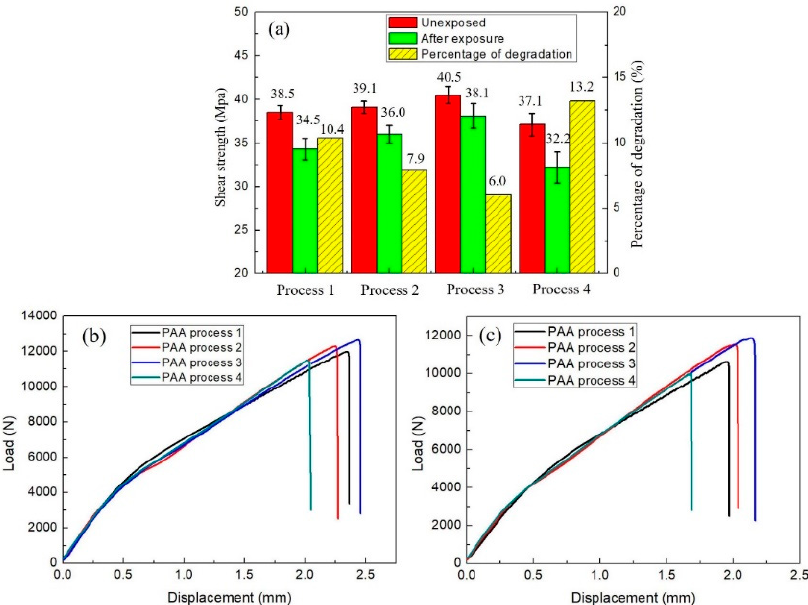
Figure 10. Effect of hot-humid exposure on joint strength: ( a ) strength degradation and load-displacement curves ( b ) before and ( c ) after exposure.